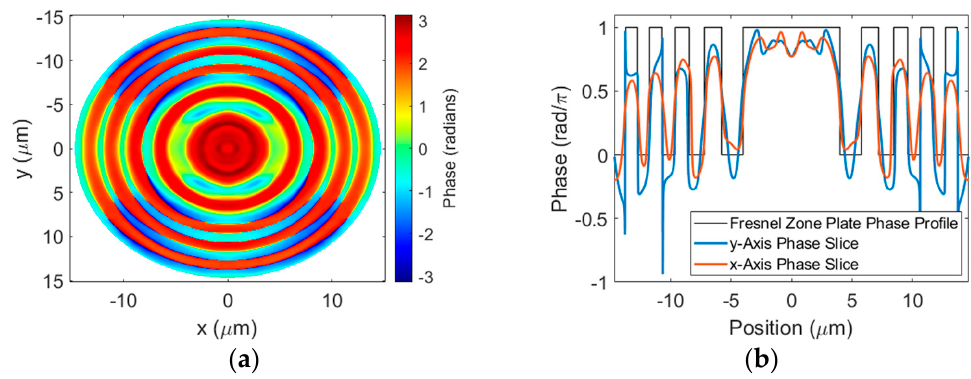
Figure 10. ( a ) Near-field phase distribution of transmitted beam with x -polarization. ( b ) Cross-sections of near-field phase taken along the vertical and horizontal axes of the lens with overlay of ideal BPFZP profile.